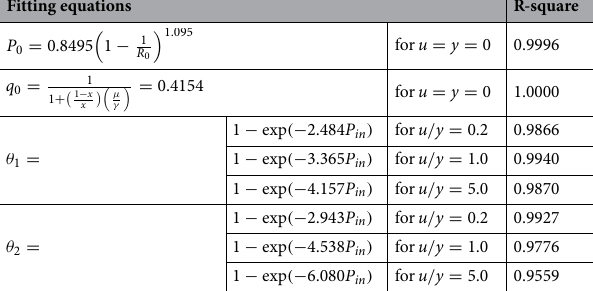
Table 2. Formulas and R-squares from curve